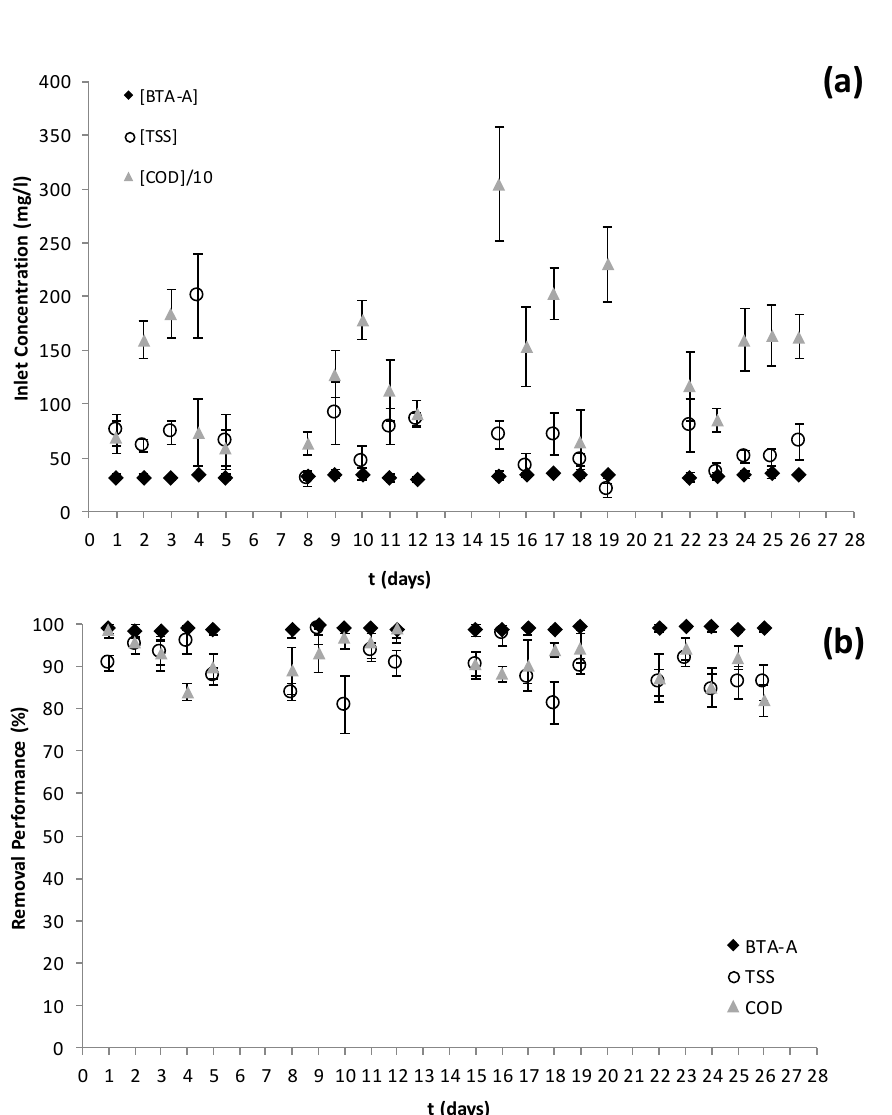
Figure 4. Results at a real plant scale on: ( a ) the inlet concentration of total suspended solids (TSS), chemical oxygen demand (COD) and benzotriazole based anticorrosive agent (BTA-A) concentration; and ( b ) the efficiency performance of the dairy wastewater treatment plant on the removal of TSS, COD and BTA-A. Note: Error bars stand for standard deviation values ( n = 4).